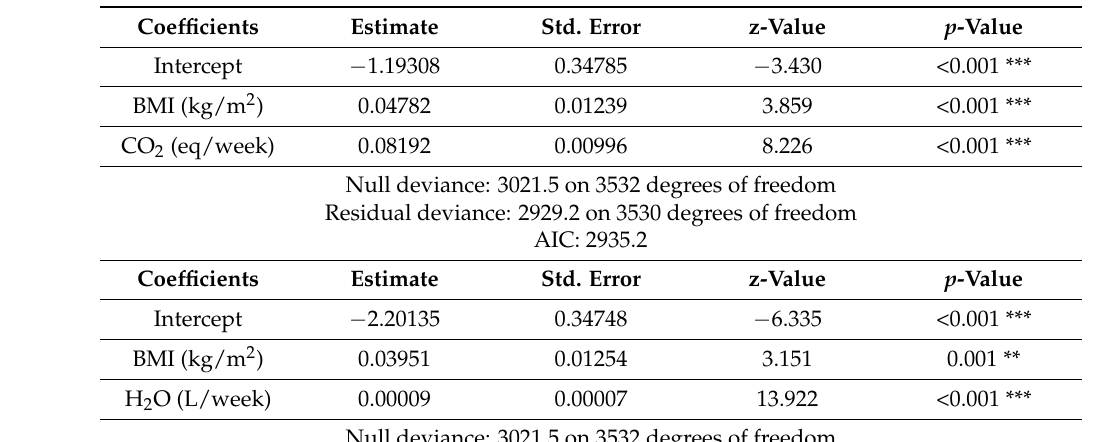
Table 3. Generalized linear model for BMI and CO 2, and BMI and H 2